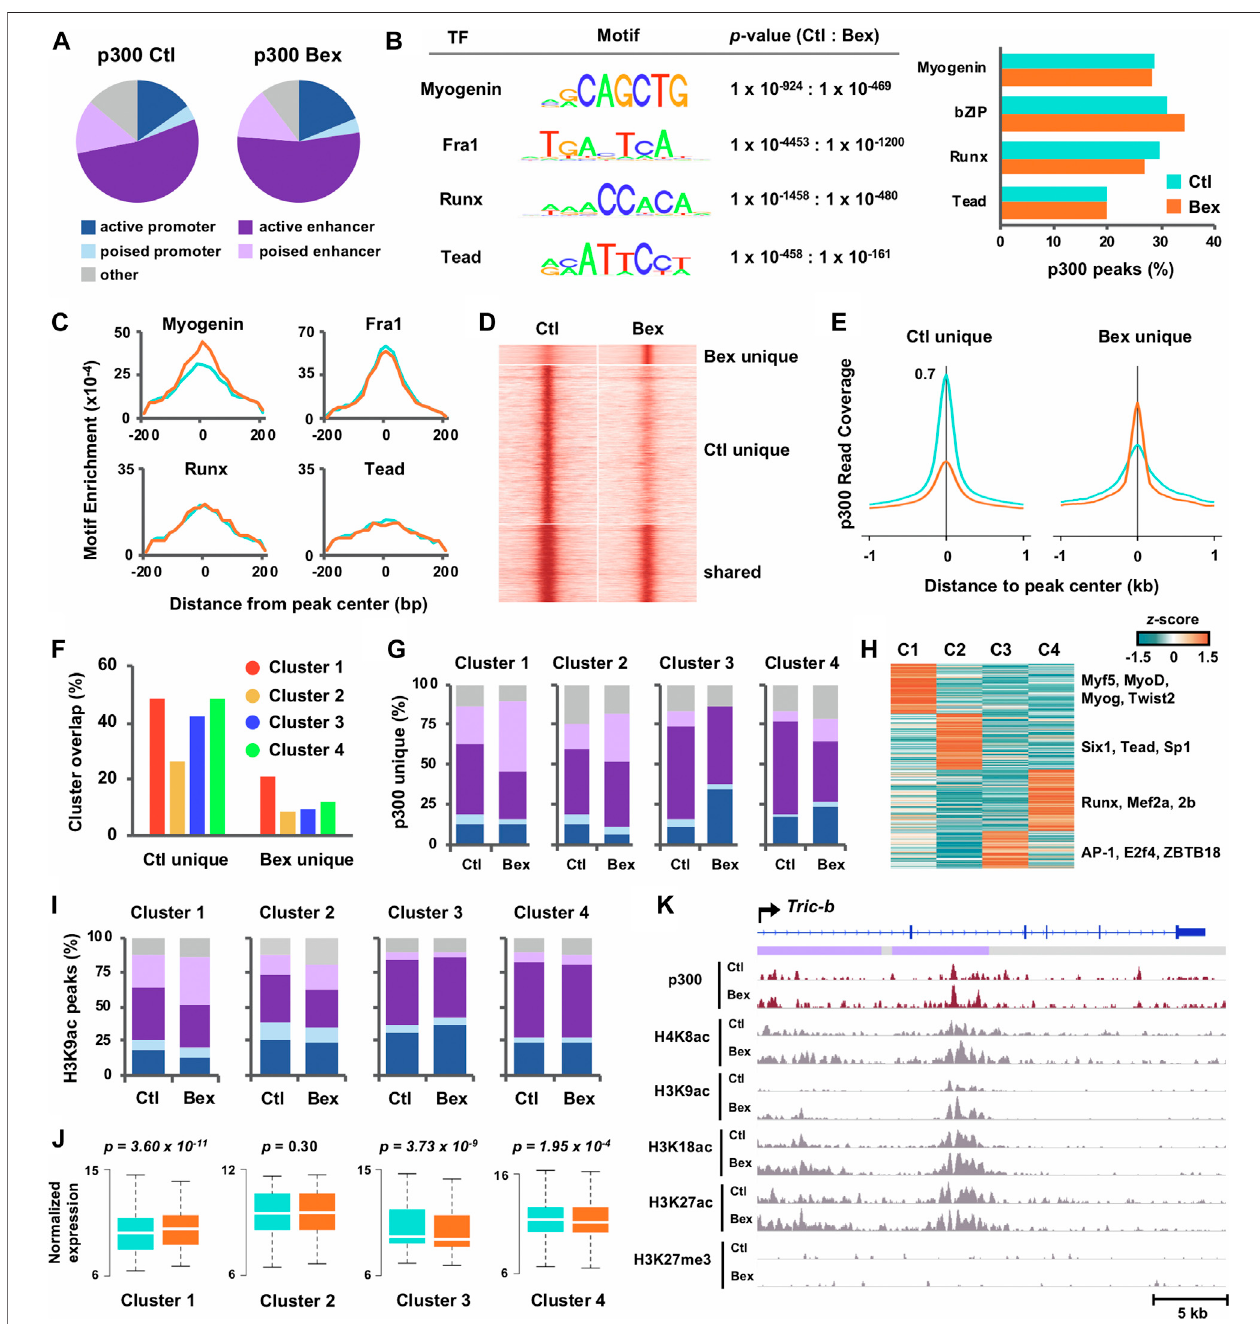
FIGURE 2 | Characterization of p300 loci in relation to chromatin state and histone acetylation in rexinoid enhanced myoblast differentiation. (A) Chromatin state distribution of p300 loci in C2C12 myoblasts differentiated for 24 h in the absence or presence of bexarotene (Ctl and Bex). (B) The most signi fi cant motifs predicted by de novo motif discovery of p300 loci are displayed with p -values and the percentage of p300 loci associated to each motif are presented to the right. (C) Distribution of motifenrichment. (D) Signalintensityforp300wascentredaroundp300peaks ( ± 1 kb), categorized intositesthatwereuniquetocontrolorbexarotene, andthose shared between both conditions. (E) Average read density of p300 across p300 loci unique to each condition. (F) Gene expression clusters as classi fi ed in Panel 1E were associated with p300 loci. The percentage of genes associated to a p300 peak in each cluster is displayed. (G) Chromatin state distribution of p300 loci unique to controlortobexaroteneandassociatedtoeachcluster. (H) Motifanalysiswasperformedforp300lociuniquetobexaroteneandassociatedtoClustersI-IV.Thez-score distributionofknownmotifsfoundthroughguidedanalysisandcategorized via k-meansclusteringisshown. (I) ChromatinstatedistributionofH3K9aclociassociatedto Clusters I-IV. (J) The expression levels of ENSEMBL genes associated to p300 loci unique to bexarotene are presented as normalized read counts measured by RNA- seq (paired Wilcoxon rank sum test). (K) Genomebrowserview ofp300, and histonemodi fi cation read density at theTric-b locus. Bluebars show Refseq gene position and the colors of ChromHMM track below correspond to the chromatin state as designated in panel (A) .